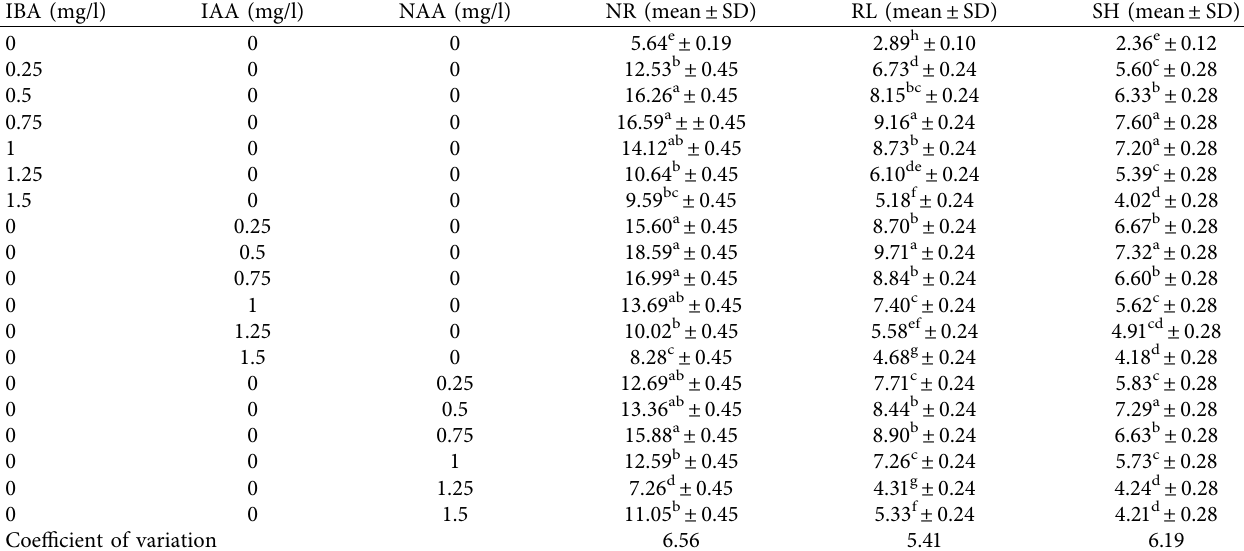
Table 10: Effect of IBA, IAA, and NAA on in vitro shoot elongation and rooting of korarima.